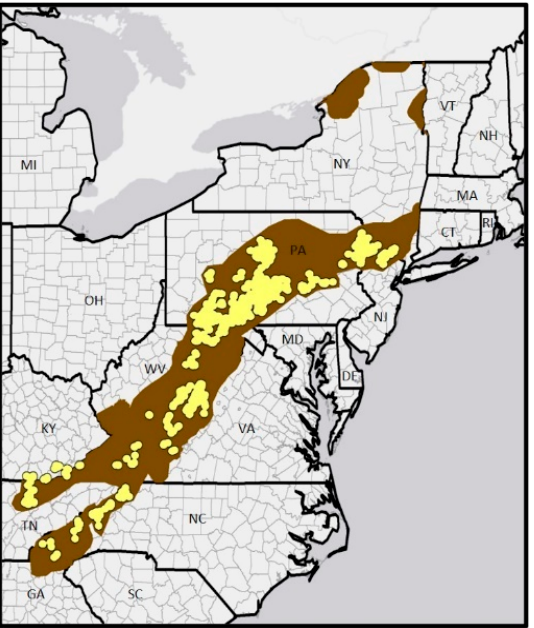
Figure 6. The Working Lands for Wildlife golden-winged warbler initiative’s boundaries (brown shading) and priority areas for conservation (PACs; yellow shading). All private landowners within the initiative’s boundaries are eligible to receive financial and technical assistance to create or enhance nesting habitats for this declining species, but properties within a PAC are ranked higher. Note: PAC boundaries were not delineated for NY, as they joined this effort in a later year.